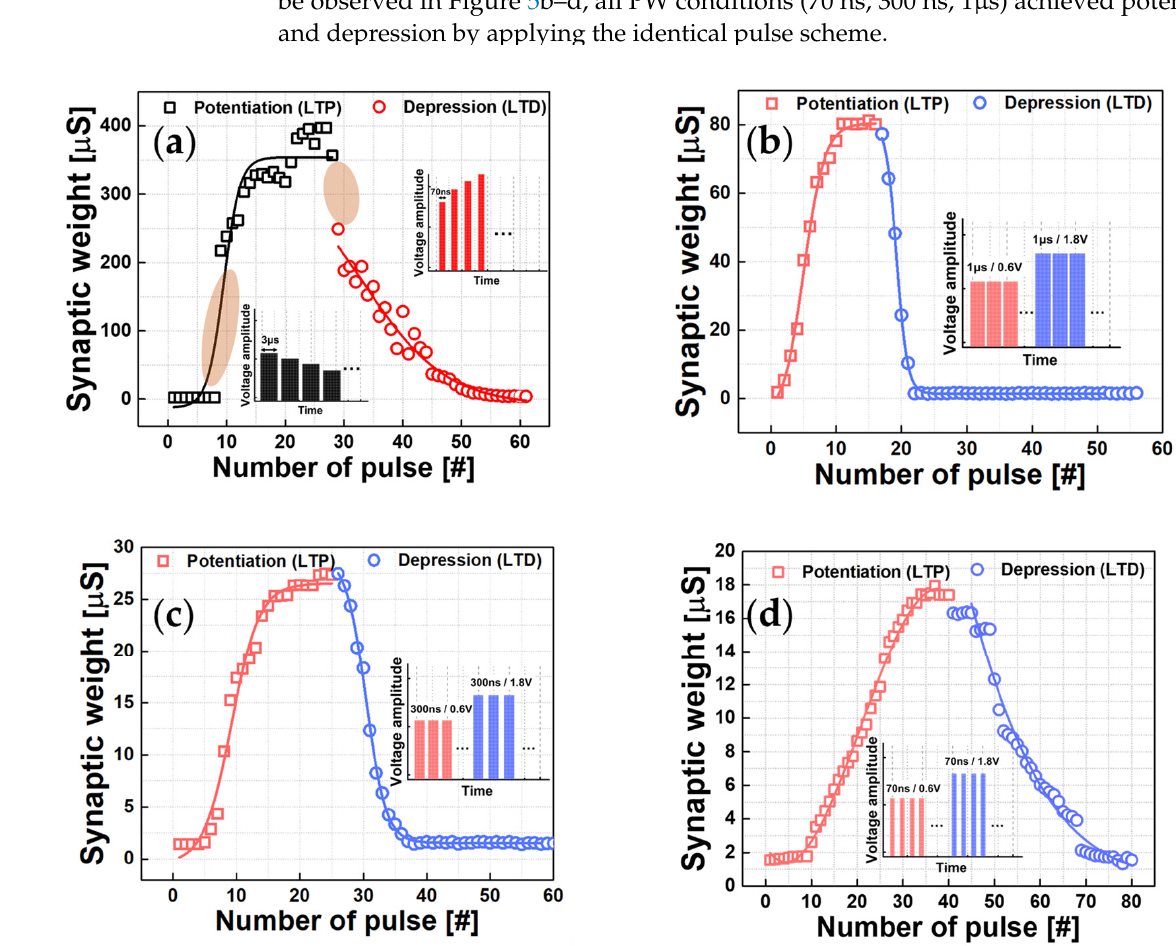
Figure 5. Conductance modulation curves obtained in GST225 alloy and (GeTe/Sb 2 Te 3 ) 16 iPCM devices. ( a ) Long-term potentiation (LTP) and long-term depression (LTD) of GST225 alloy, with the pulse scheme of the pulse train applied for LTP and LTD (inset). (The brown circles indicate the ranges in which conductance values change abruptly.) LTP/LTD obtained by applying an identical pulse scheme to a (GeTe/Sb 2 Te 3 ) 16 iPCM with ( b ) a potentiation pulse of 1 µ s PW and 0.6 V and a depression pulse of 1 µ s PW and 1.8 V, ( c ) a potentiation pulse of 300 ns PW and 0.6 V and depression pulse of 300 ns PW and 1.8 V and ( d ) a potentiation pulse of 70 ns PW and 0.6 V and a depression pulse of 70 ns and 1.8 V. Table 1. Summary of synaptic characteristics of GST225 alloy and (GeTe/Sb 2 Te 3 ) 16 iPCM.